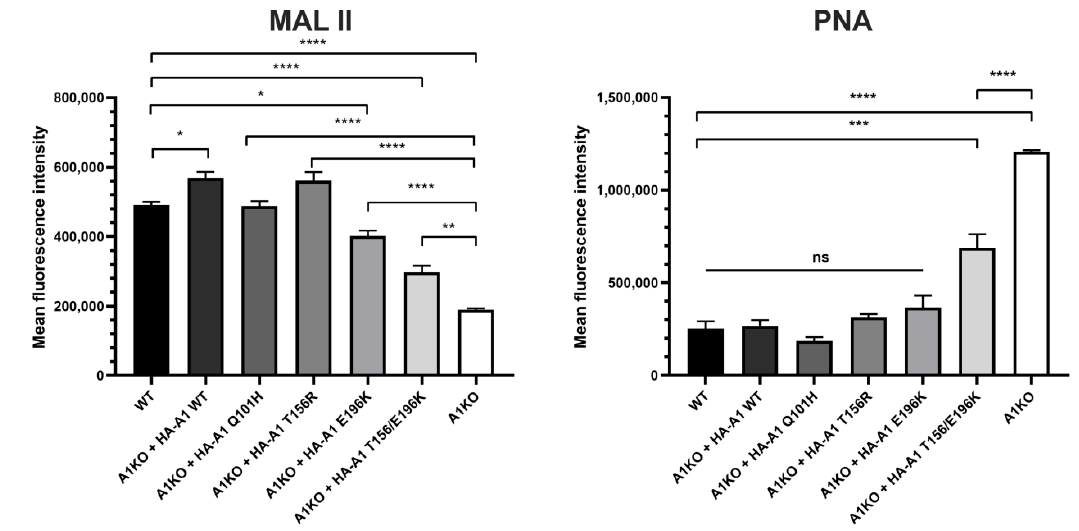
Figure 3. Analysis of reactivity of cell surface glycoconjugates with selected lectins using flow cytometry. PNA, Arachis hypogaea lectin; MAL II, Maackia amurensis lectin II. Data are presented as mean fluorescence intensity of three independent biological replicates, each performed for 10,000 cells ± SEM. For statistical analysis of the data, one-way ANOVA with Tukey’s post-hoc test was used. Knock-out cells overexpressing CST variants were compared with both wild-type and knock-out cells. Statistical significance was assigned top-value < 0.05. ns, not significant; *, p < 0.05; **, p < 0.01; ***, p < 0.001; ****, p < 0.0001.